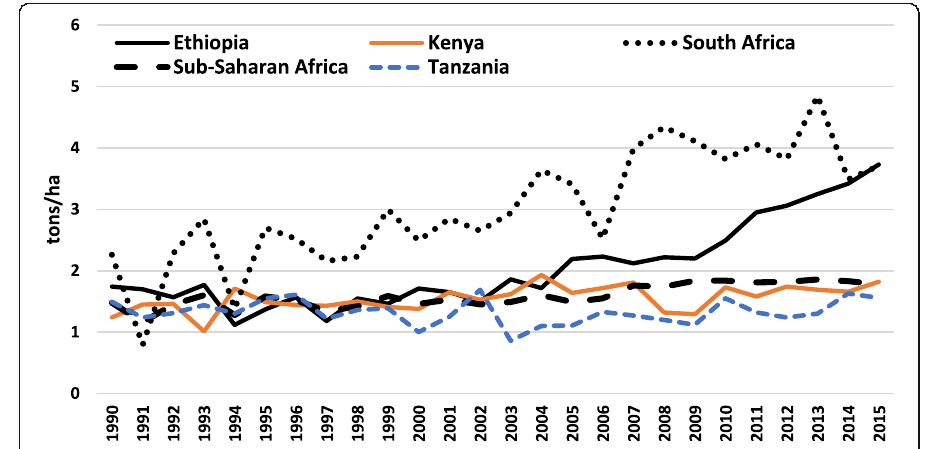
Fig. 3 Maize yield in major Sub-Saharan African countries (1990 – 2015). Source: Author ’ s calculation using USDA data (United States Department of Agriculture (USDA)